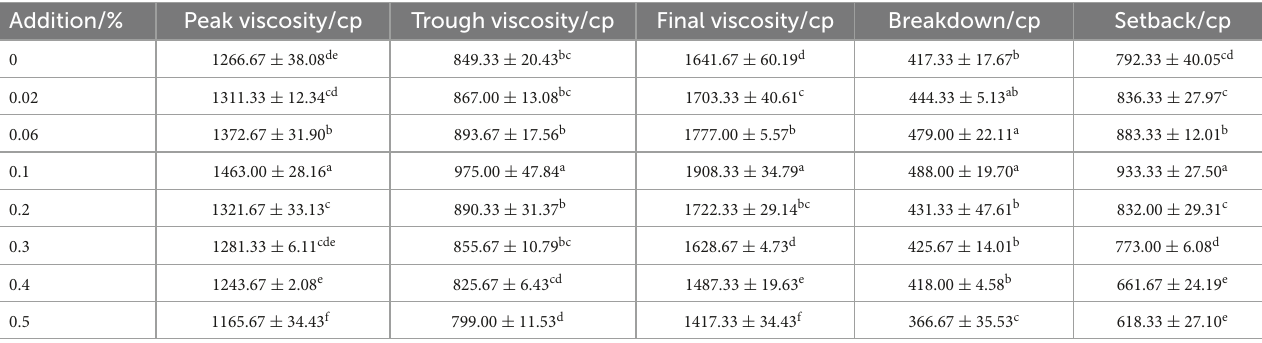
TABLE 3 Effect of sodium bicarbonate on the pasting properties of rice flour.